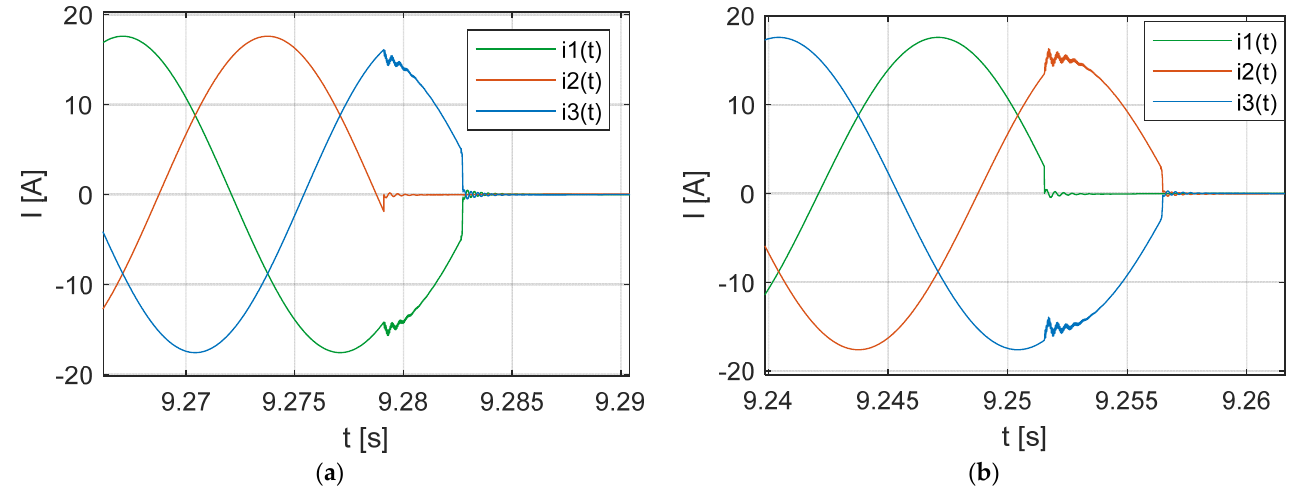
( b ) Figure 6. Measurement results ( a ) Vacuum circuit breaker (VCB); ( b ) Oil circuit breaker (Oil CB).